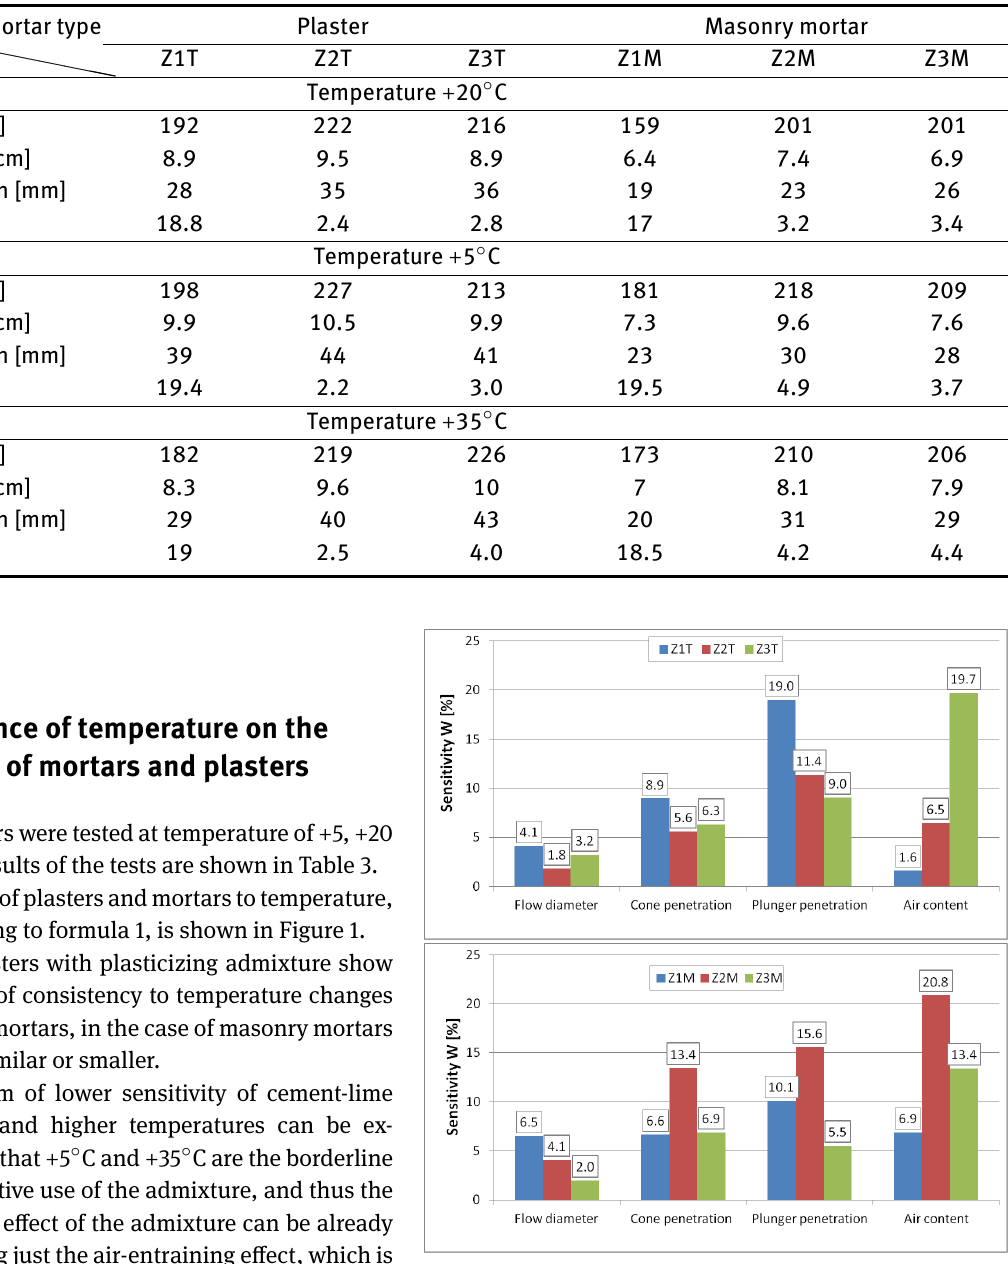
even small changes are high in